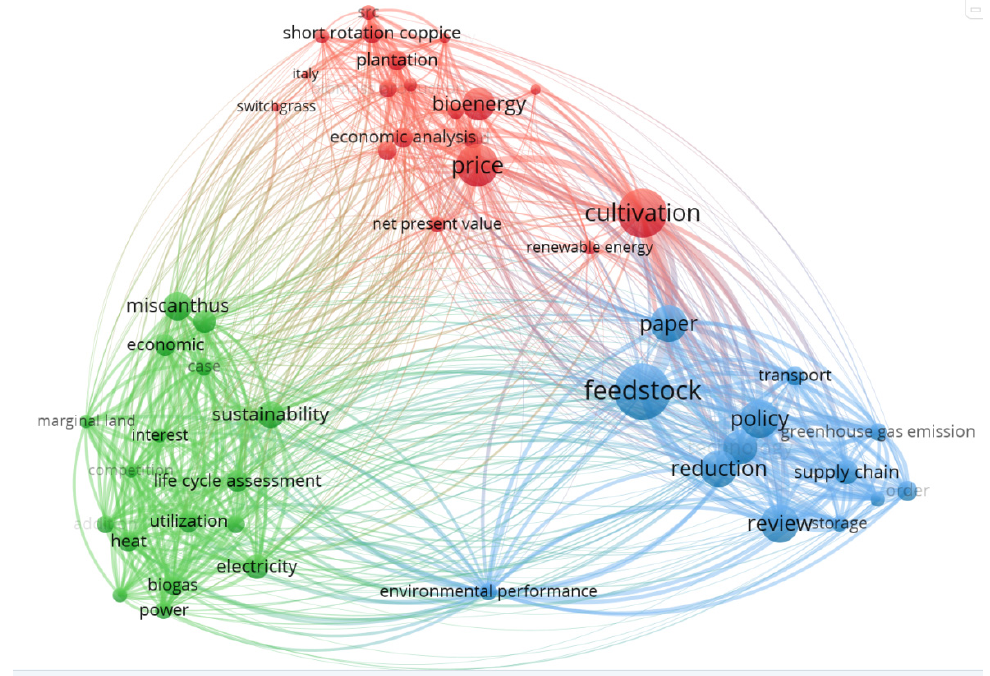
Figure 4. Network visualization of papers selected for analysis.